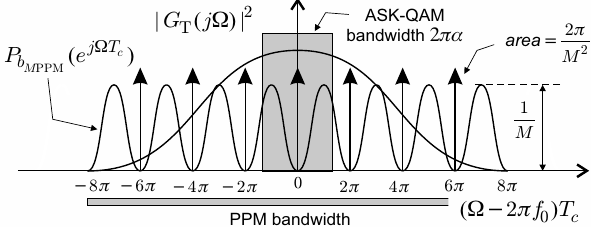
Figure A4. Spectral representation of band-pass PPM signals.